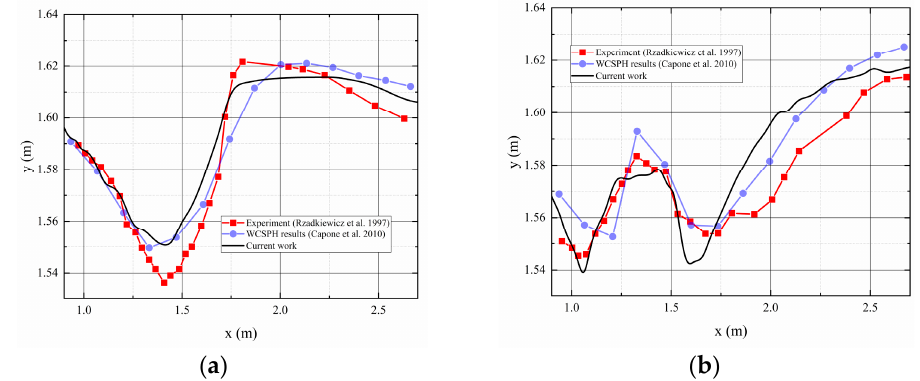
Figure 17. Comparison of surge wave profiles. ( a ) t = 0.4 s; ( b ) t = 0.8 s.